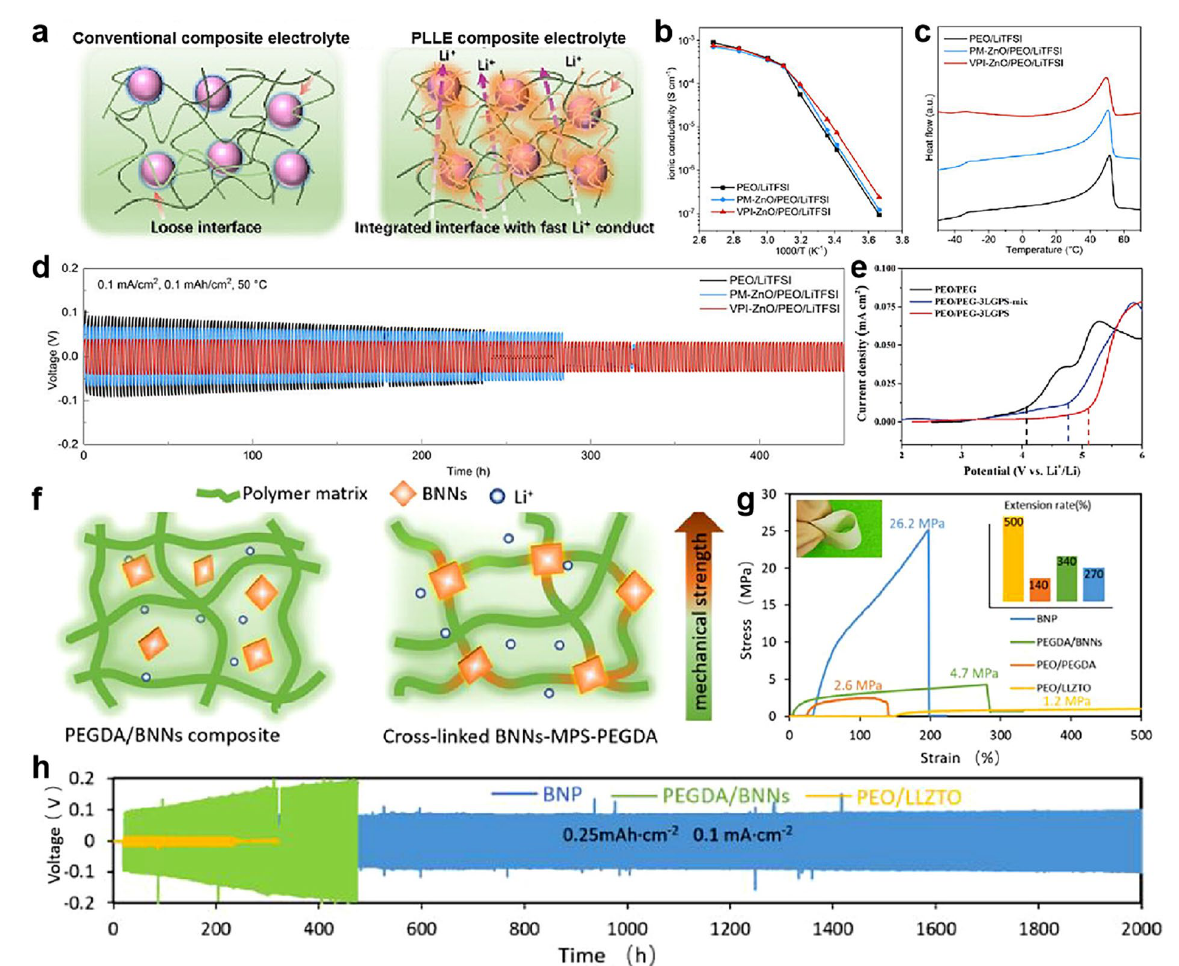
Fig. 10 a Schematic figures of the synergistic effect of the components in CSEs. Reproduced with permission [97]. Copyright 2021, Wiley– VCH. b The relationship between ionic conductivity and temperature for each electrolyte. c DSC profiles of each electrolyte. d Long-term gal- vanostatic cycling of Li–Li symmetric cells. b‑d Reproduced with permission [180]. Copyright 2021, Elsevier. e LSV curves of each